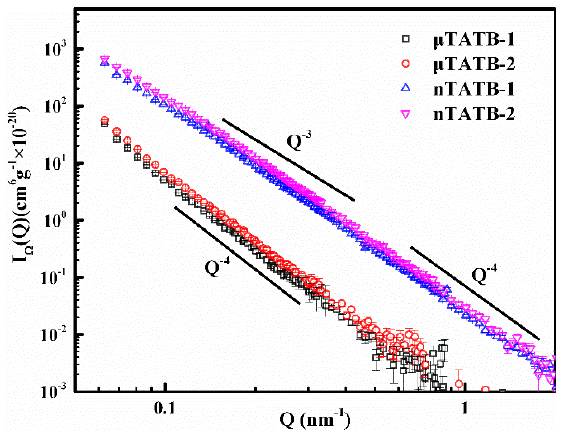
Figure 3. Shape function (external interfacial features) obtained far from the contrast match point. All samples show power-law scattering.